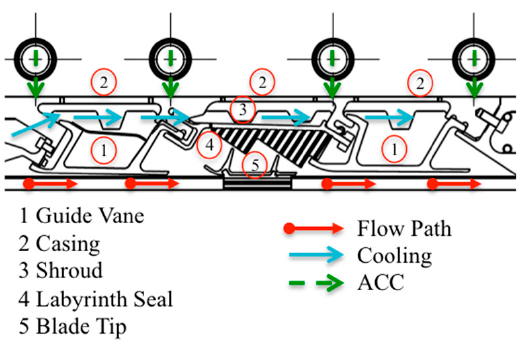
Figure 9. Main components and mass flow rates [14].